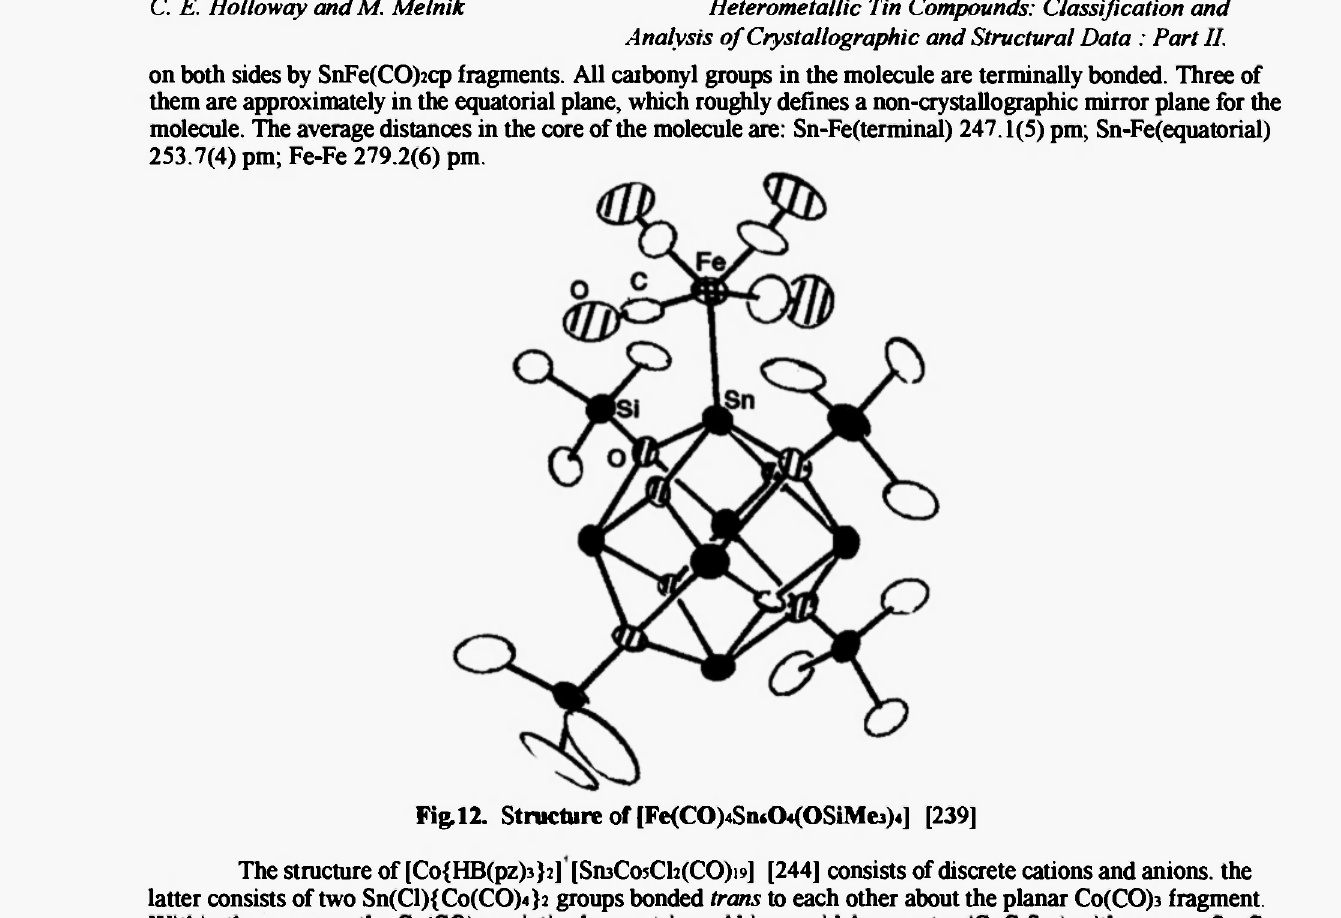
Fig.12. Structure of (Fe{C0)4Snt04(0SiMe3)«] [239]